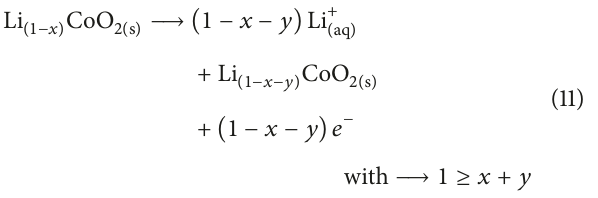
Figure 7: Process of MB discoloration (color removal) versus time for pH = 7.02 with different conditions of H 2 O 2 , spent cathode (SC), and MB solution.